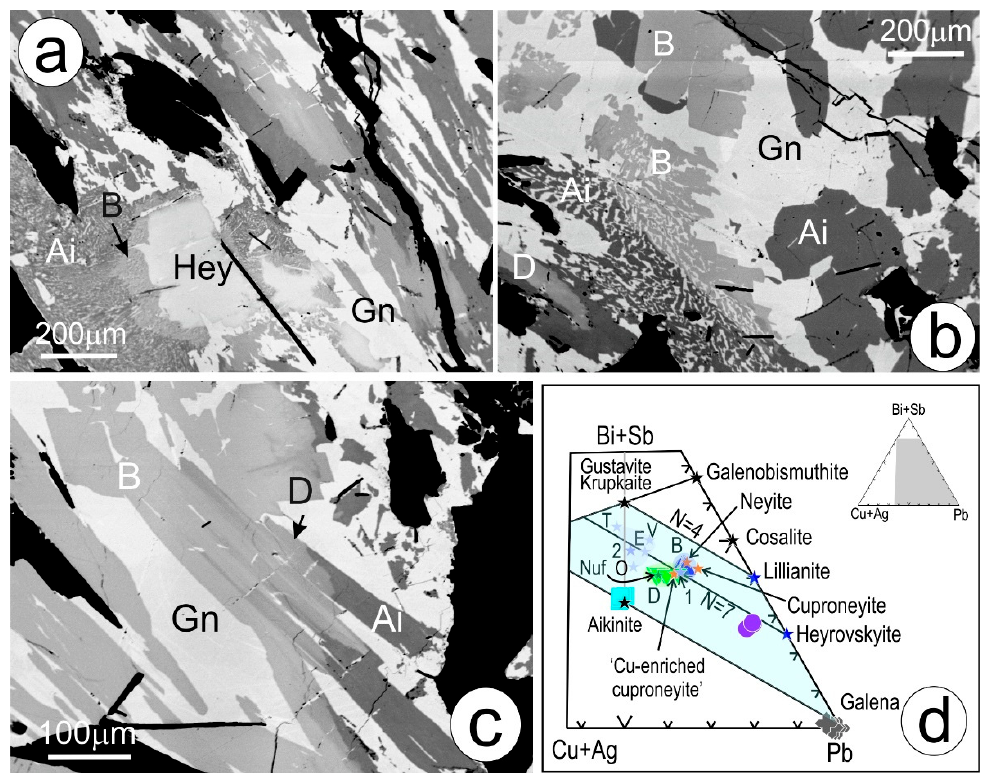
Figure 3. BSE images ( a – c ) showing typical symplectitic and lamellar intergrowths between Bi-ss and galena; ( d ) (Cu, Ag)-(Bi, Sb)-Pb ternary diagram, showing the composition of sulphosalts and sulphides throughout the entire sample (polished block). Star symbols represent ideal phases.